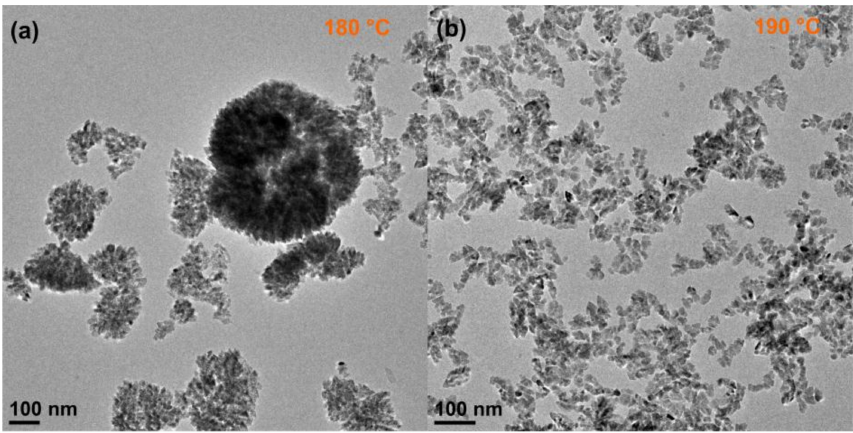
Figure 3. TEM images of Co 0.15 Zn 0.85 O synthesized at ( a ) 180 ◦ C and ( b ) 190 ◦